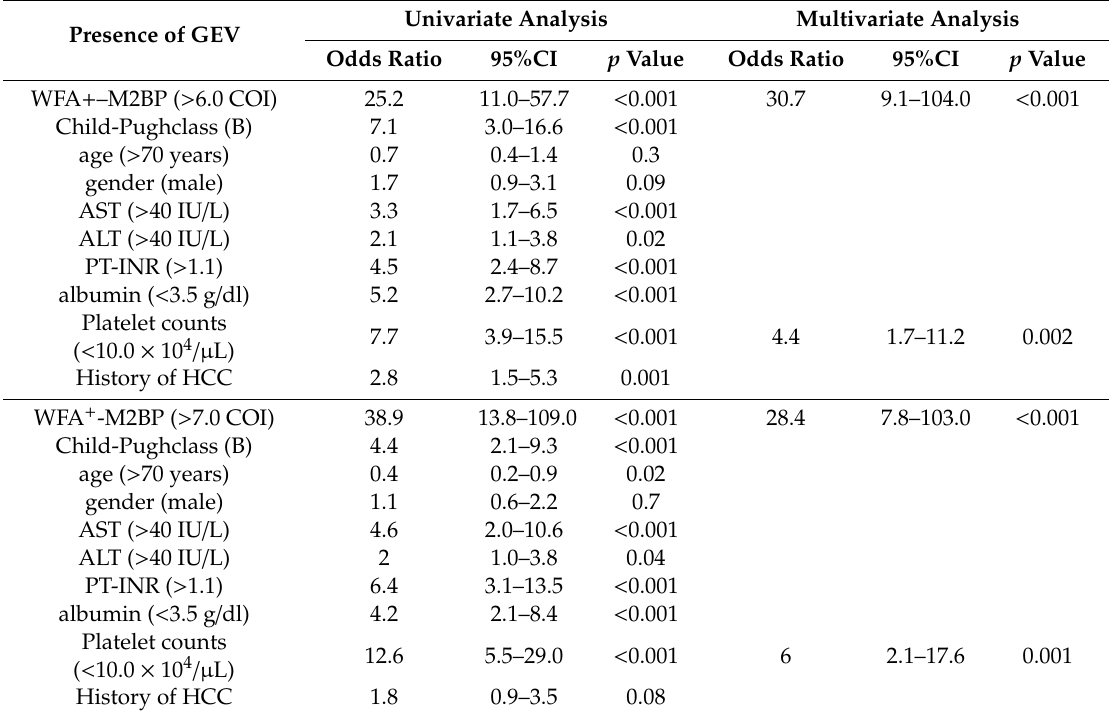
Table 3. Factors associated with presence of GEV and large GEV.